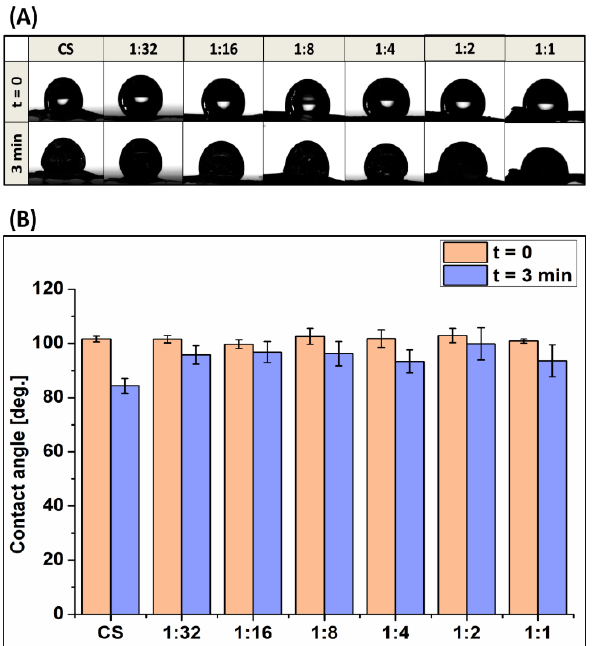
Figure 5. ( A ) Profiles of water droplets on CS and Ga (III)-CS samples, ( B ) average contact angle of water droplets on all investigated samples, immediately and 3 min after